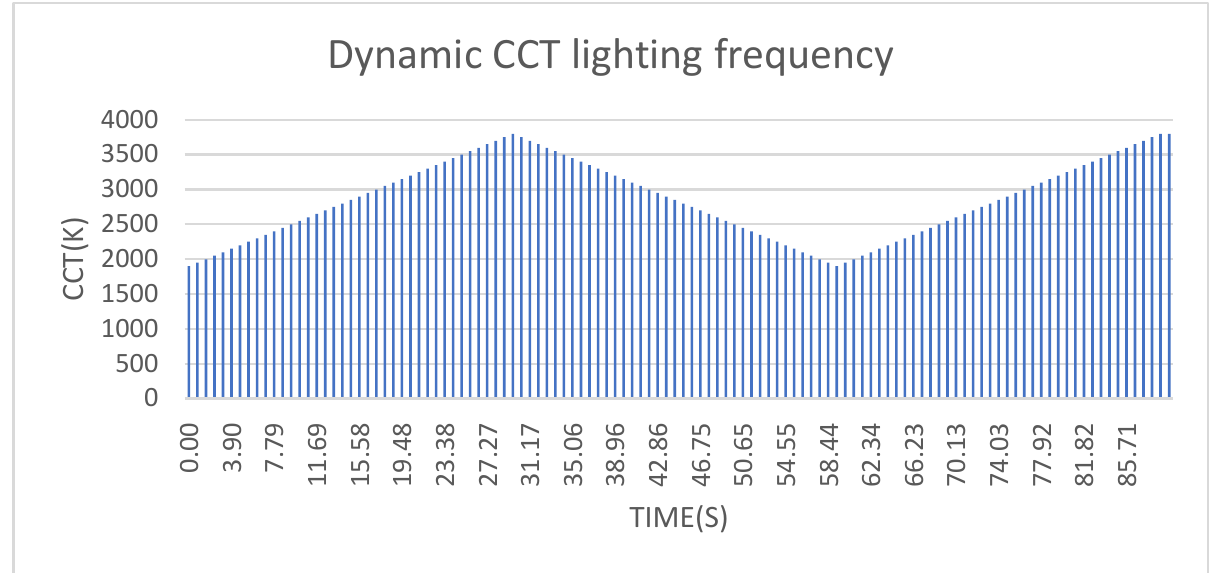
Figure 2. This is the changing frequency of Dynamic CCT lighting, which is changed by 50 K (CCT) each time, rising from the lowest CCT 1900 K to the highest CCT 3800 K (for example: 1900 K, 1950 K, 2000 K, 2050 K, 2100 K, … , 3800 K), and then Descending from 3800 K to 1900 K every 50 K (e.g., 3800 K, 3750 K, 3700 K, 3650 K, … , 1900 K) in one cycle and complete within one minute, then repeat.